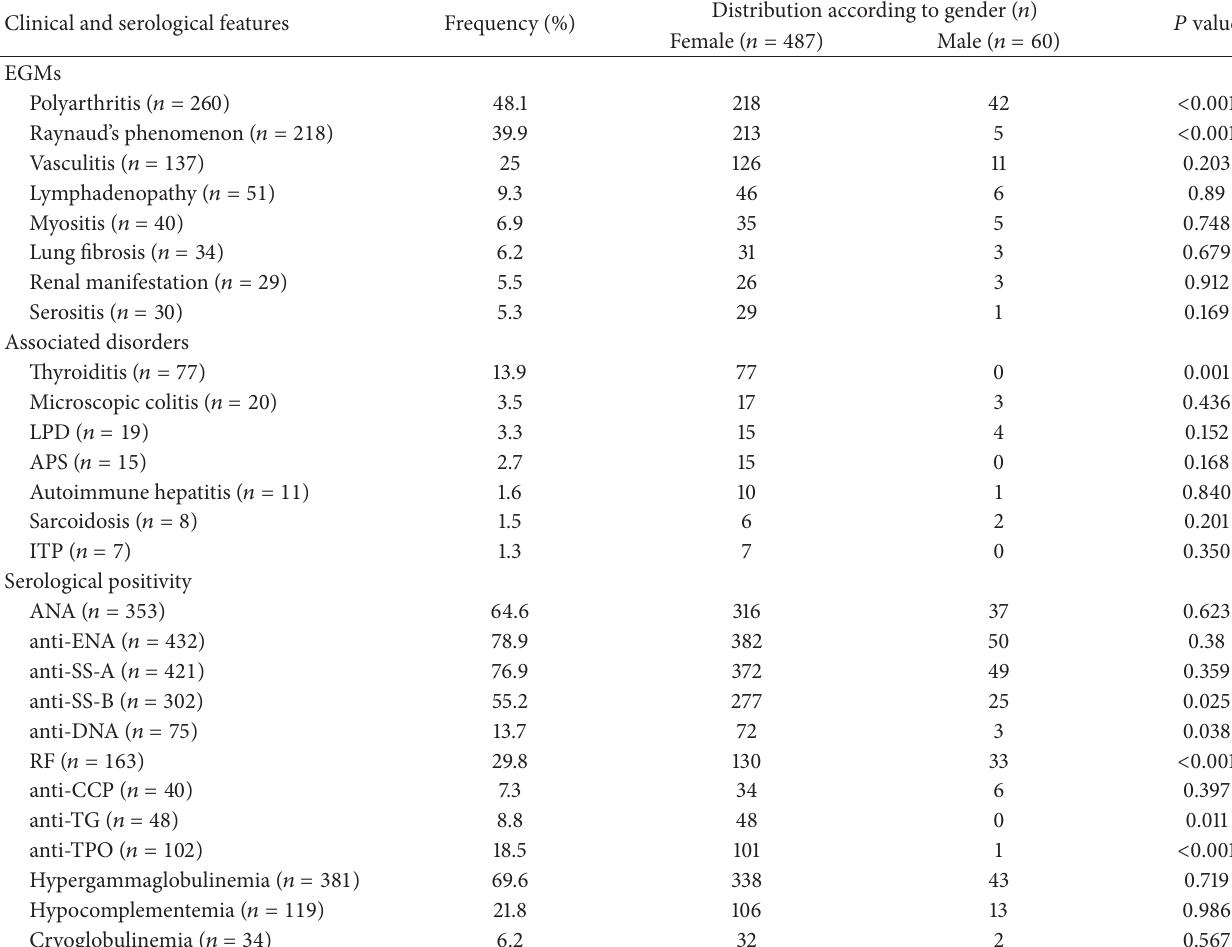
Table 3: Frequency of clinical and immunoserological features during the disease course. Clinical and serological